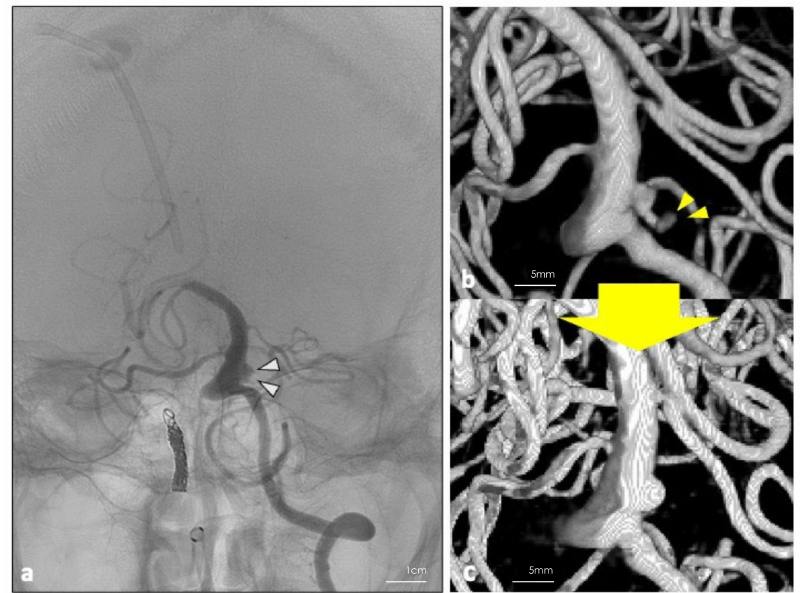
Figure 3. ( a ) DSA was performed 26 days post operation. White arrowheads show the residual blood flow in the aneurysm. ( b , c ) Three-dimension reconstruction of the digital subtraction angiog- raphy performed 7 days before and 26 days after the operation. Disappearance of the bleb (yellow arrowheads) and shrinkage of the residual blood flow inside the aneurysm were